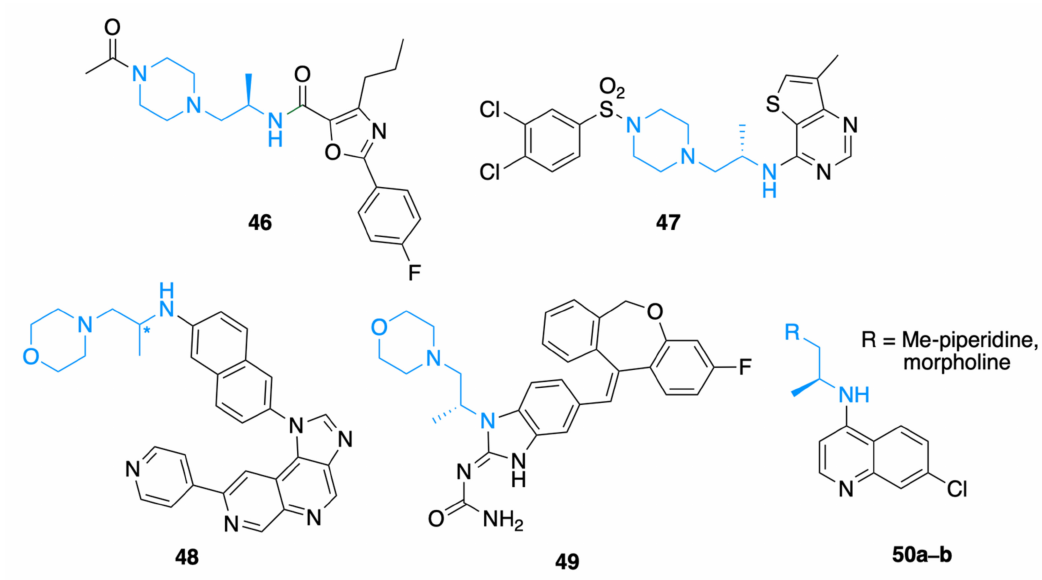
Figure 10. Chiral drug candidates and HTS hits containing 3D-amine heterocycles with substituents bearing asymmetric amine functionality.